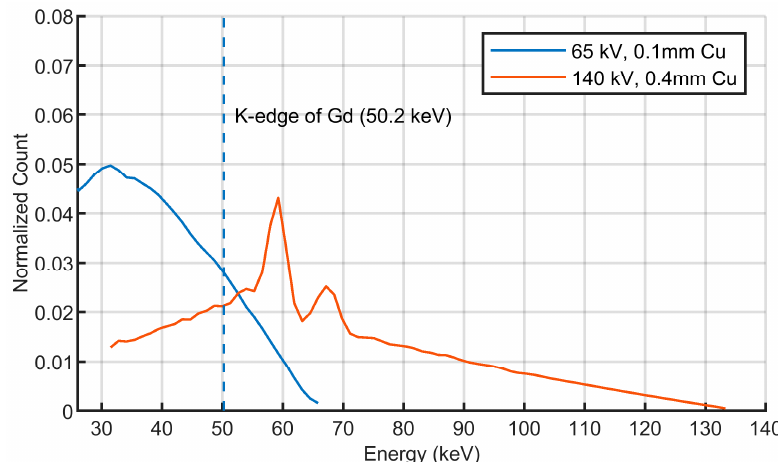
Figure 7. Incident spectrum for Cone-beam computed tomography (CBCT) (65 kV, filtered with 0.1 mm Cu) and XFCT (140 kV, filtered with 0.4 mm Cu) measured by eV-3500 detector.